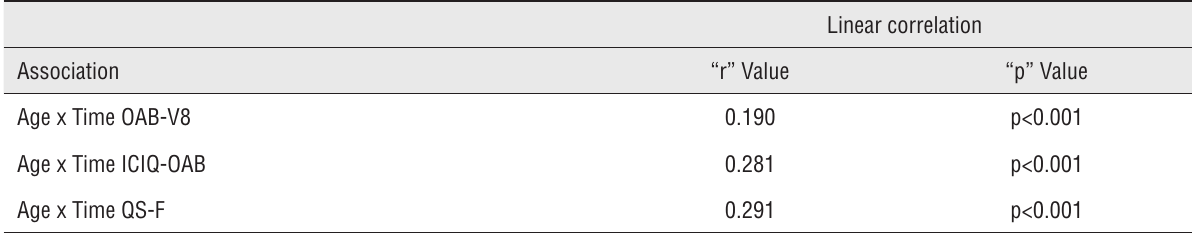
Table 2 - pearson linear correlation: age versus time to answer the questionnaires.